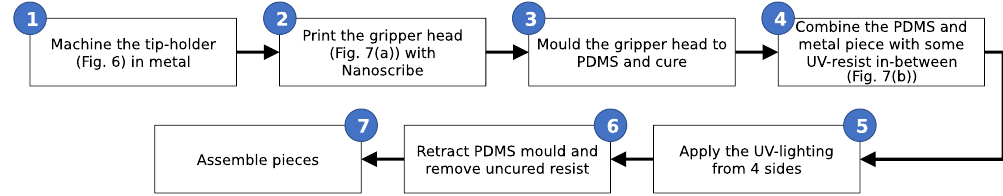
Figure 9. Flow chart for the manufacturing of the moulded gripper head on top of a macroscopic component.